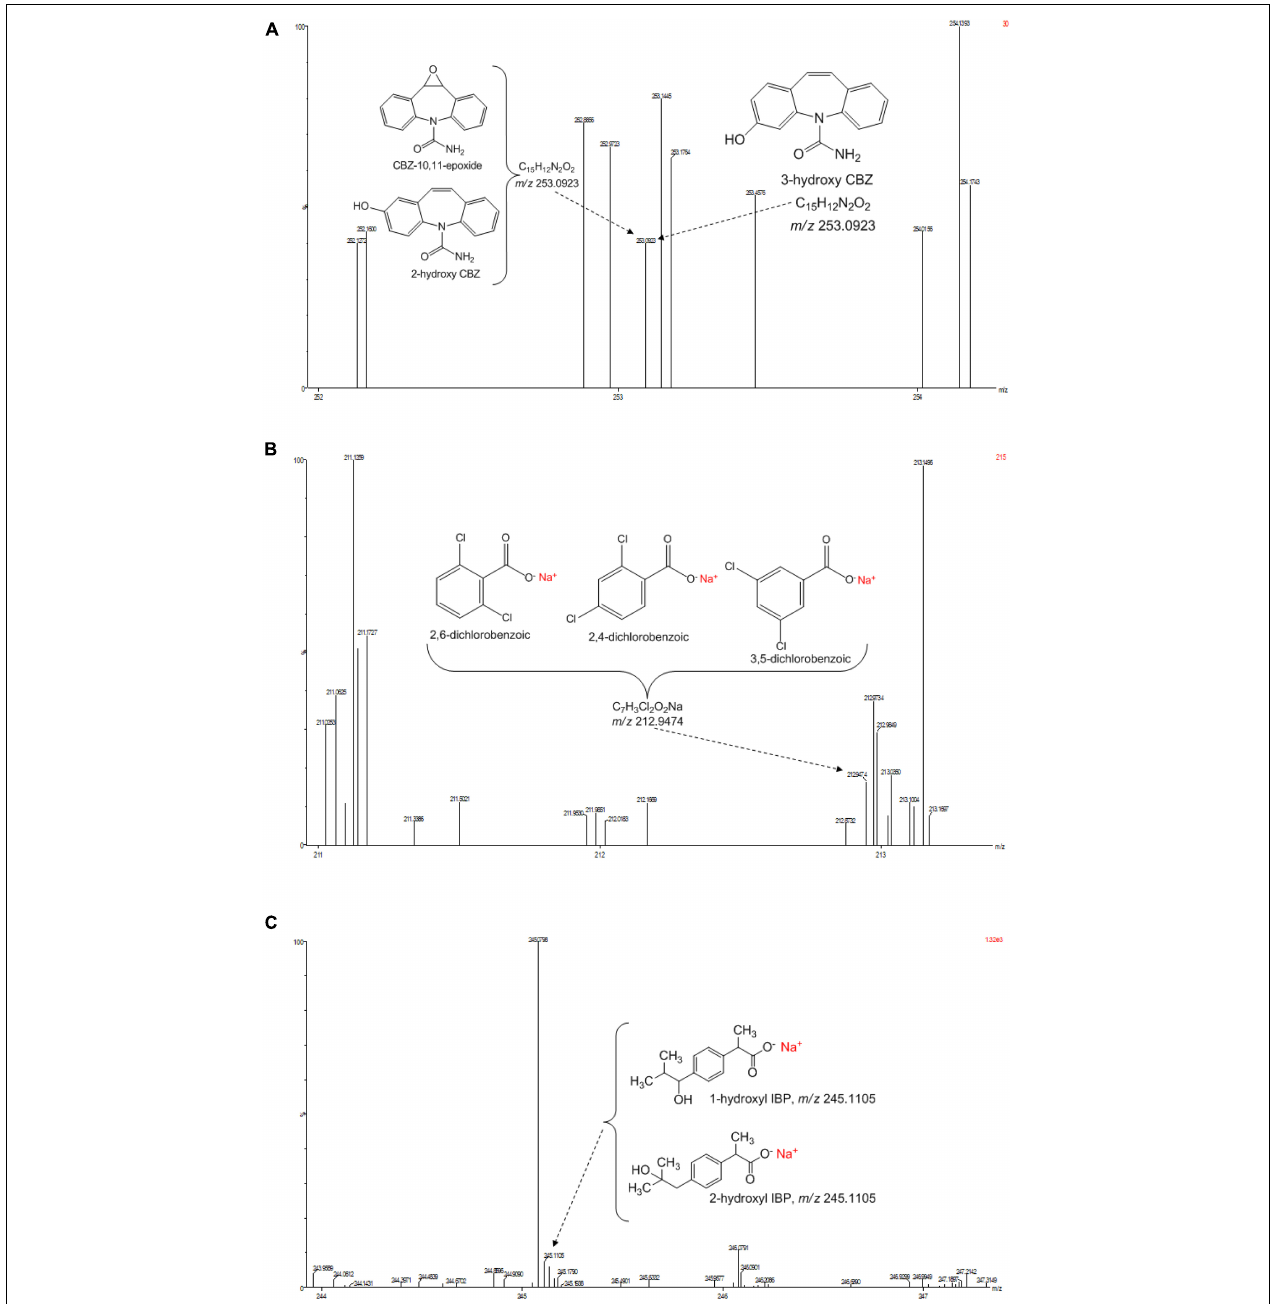
FIGURE 5 | (A) Selected UPLC-(+)-ESI-QtoF-MS spectrum of the suggested analyte ion fragments from CBZ. (B) Selected UPLC-(+)-ESI-QtoF-MS spectrum of the suggested analyte ion fragments from DCF. (C) Selected UPLC-(+)-ESI-QtoF-MS spectrum of the suggested analyte ion fragments from